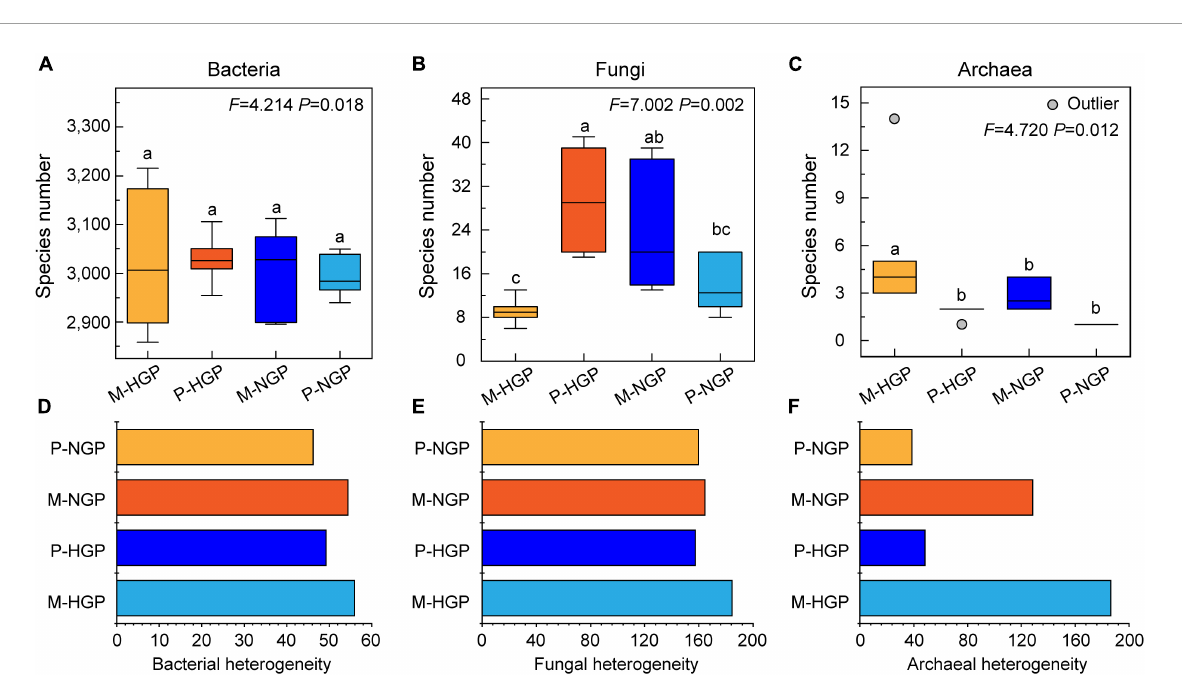
fungi, the number of species clusters increased from 4 to 10 in the matrix but decreased from 11 to 3 in the patch, suggesting that the correlations were inconsistent for changes between fungi and bacteria. The response of archaea to GE was similar to that of bacteria to GE ( Figure 4